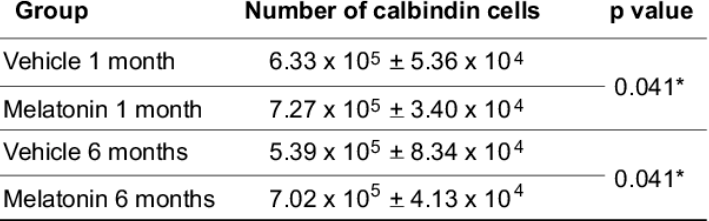
Figure 3. Number of calbindin-positive cells in the granular cell layer. ( a ) Representative pictures show calbindin expression in the granular cell layer (GCL). Images also show the molecular layer (ML), hilus (H), and the initial part of the mossy fiber projection (MFPs). The image in A.1 corresponds to a bright field and the image in A.2 is the inverted picture displayed in A.1. The dashed line indicates the GCL. Scale bar = 150 µm. ( b ) Calbindin-positive cells were quantified in the granular cell layer in the dentate gyrus. Two-way ANOVA yielded the following values: Factor A (treatment): F1,19 = 5.22, p = 0.041. Factor B (time): F1,19 = 1.13, non-significant (n.s.) Interaction AxB: F1,19 = 0.376, n.s. However, the significant main effect in the number of calbindin-positive cells was caused by treatment with melatonin (*).